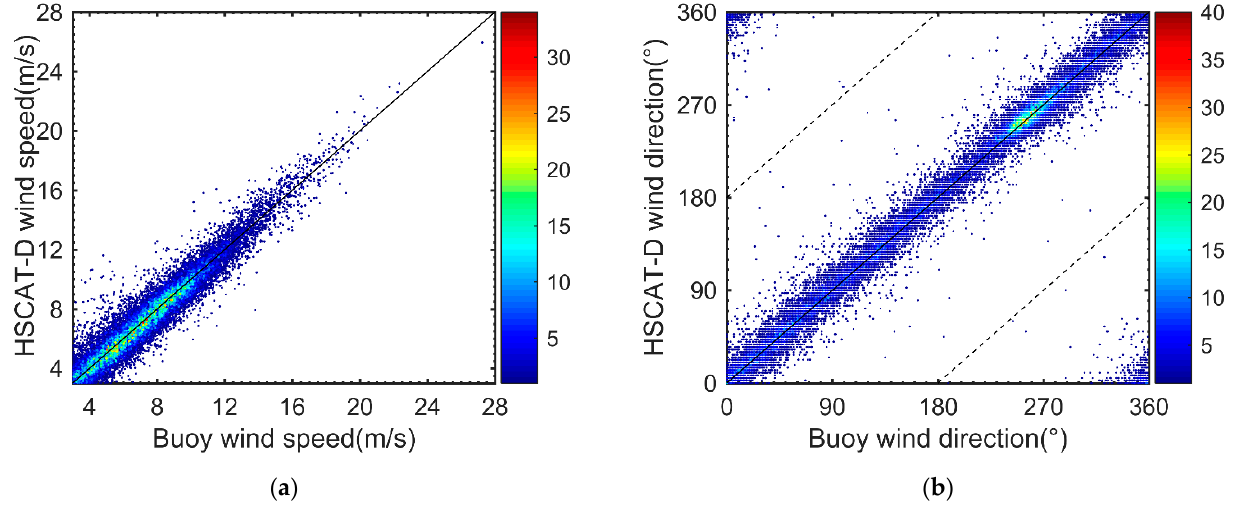
Figure 2. Scatterplots of wind spee d ( a ) and direction ( b ) derived from HSCAT-D versus NDBC buoy winds. buoy